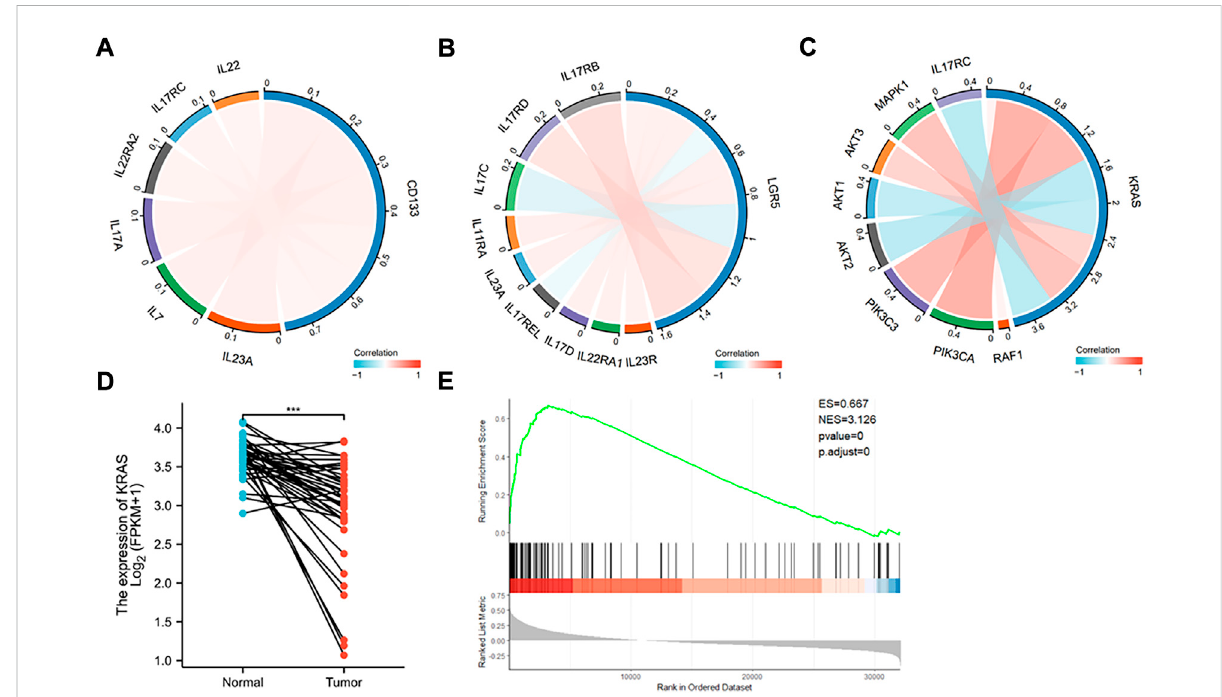
Database analysis of stem and K-Ras gene expressions in colon cancer. (A) Chordal graph of the correlation between the expression of CD133 and in fl ammatory genes. The expression of CD133 was found to positively correlate with IL-7, IL-17A, IL-17RC, IL-22RA2, IL-22, and IL-23A. (B) Chordal graph of the correlation between the expression of Lgar5 and in fl ammatory genes. The expression of LGR5 was found to positively correlate with IL-11RA, IL-17RB, IL-17RD, IL-17D, IL-22RA1, IL-23R, and IL-23A, and negatively correlate with IL-17C, and IL-17REL. (C) Chordal graph of the correlation between the expression of K-Ras and in fl ammatory genes. The expression of K-Ras was found to positively correlate with RAF1, PIK3CA, PIK3C3, AKT3, and MAPK1, and negatively correlate with AKT1, AKT2, and IL-17RC. (D) K-Ras gene expression based on the TCGA database analysis in normal and colon cancer tissues (***: p < 0.001). (E) GSEA analysis indicated signi fi cant correlations between K-Ras mRNA expressionandstemness-relatedgenesignatures.GSEAfromthepubliclyavailableGEOdatabase(Coloncancer)hasshownpositivecorrelation( p < 0.05) between K-Ras expression and stemness-related gene